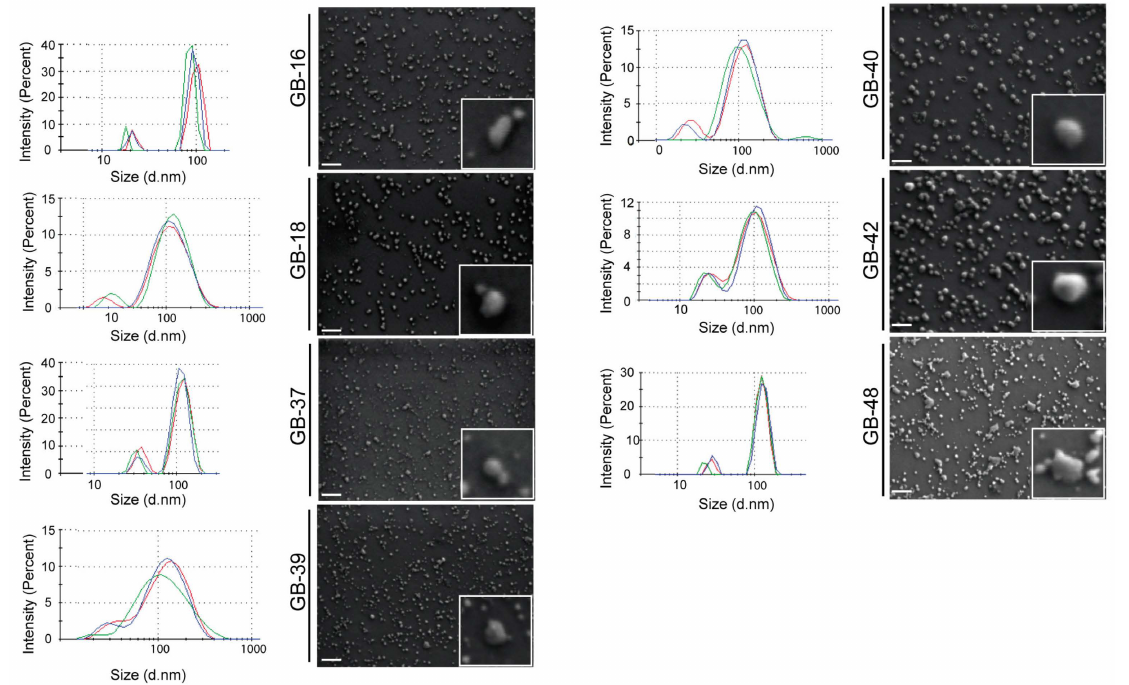
Figure 3. Size characterization of small EVs particles. Size and morphology of the seven GBM cell lines’ small EVs were visualized by using Dynamic Light Scattering (DLS) and Field Emission Scan- ning Electron Microscopy (FESEM). White boxes show an optical magnification of a representative small EV. Scale bars 200 nm. GBM, glioblastoma; EVs, extracellular